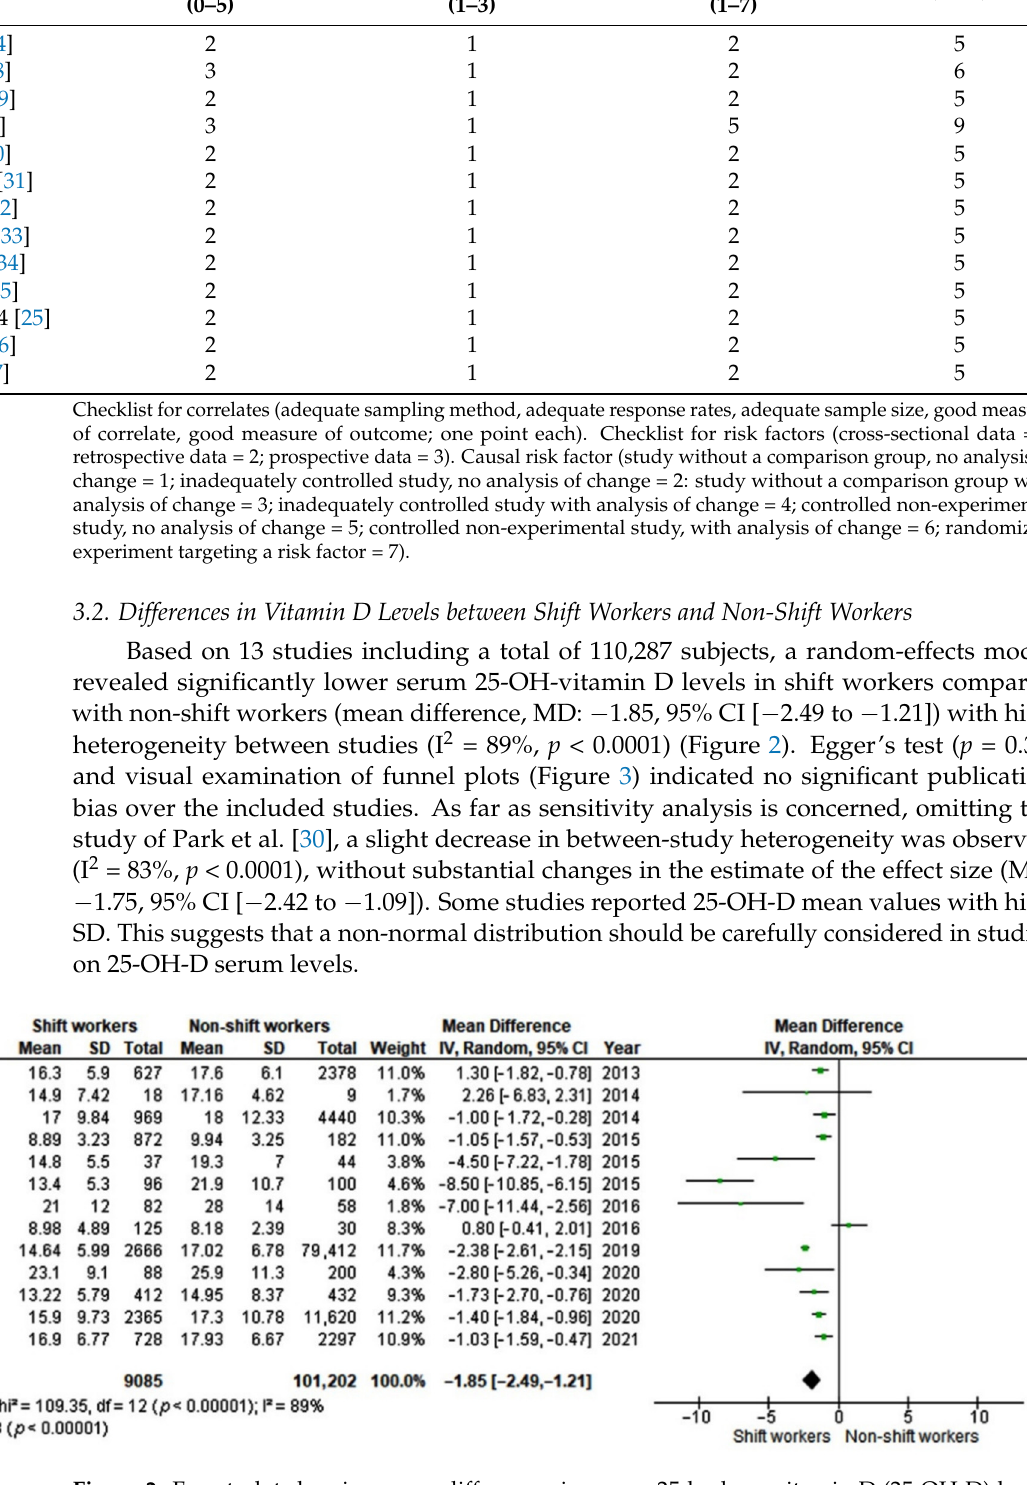
Figure 3. Funnel plot of the included studies showing no significant asymmetry. 3.3. Differences in Vitamin D Levels between Shift Workers and Non-Shift Workers—Subgroup Analysis 3.3.1. Methods of Measurement In order to explore the source of heterogeneity, a subgroup analysis according to the methods of serum 25-OH-D level measurement was performed. The test for subgroup differences indicated that there was no statistically significant subgroup effect ( p = 0.17), suggesting that the method of measurement does not modify the effect of shift work on serum vitamin D levels. However, most of studies reported vitamin D levels measured by chemiluminescent immunoassay (CLIA), whereas other methods were used in a smaller number of studies (Figure 4). In addition, in three large studies [26,28,30], the method of measurement was not specified.